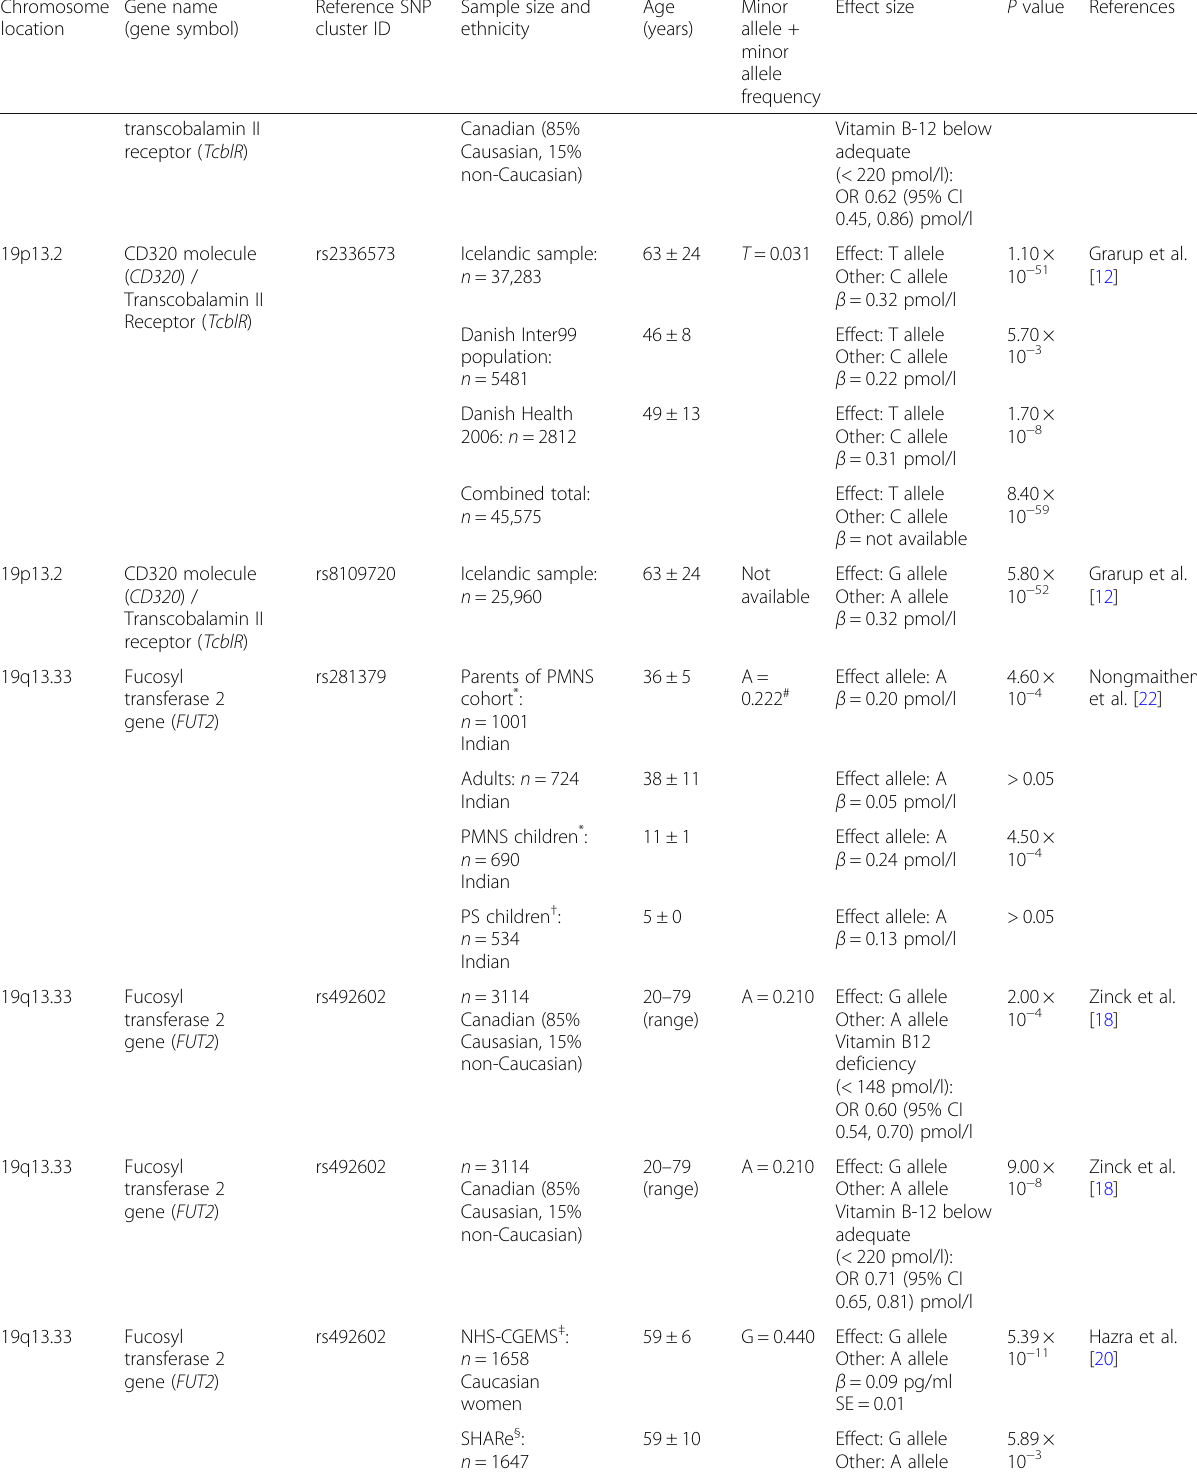
Table 1 Genome-wide association studies showing the association of SNPs with vitamin B12 concentrations. Genome-wide association studies testing the association between SNPs and vitamin B12 concentrations. The chromosome location, gene name, reference SNP cluster ID, sample size and ethnicity, mean age, observed frequency of the minor allele in the population, effect size and P value are shown in the table. The order of SNPs reflects the order of the chromosome location